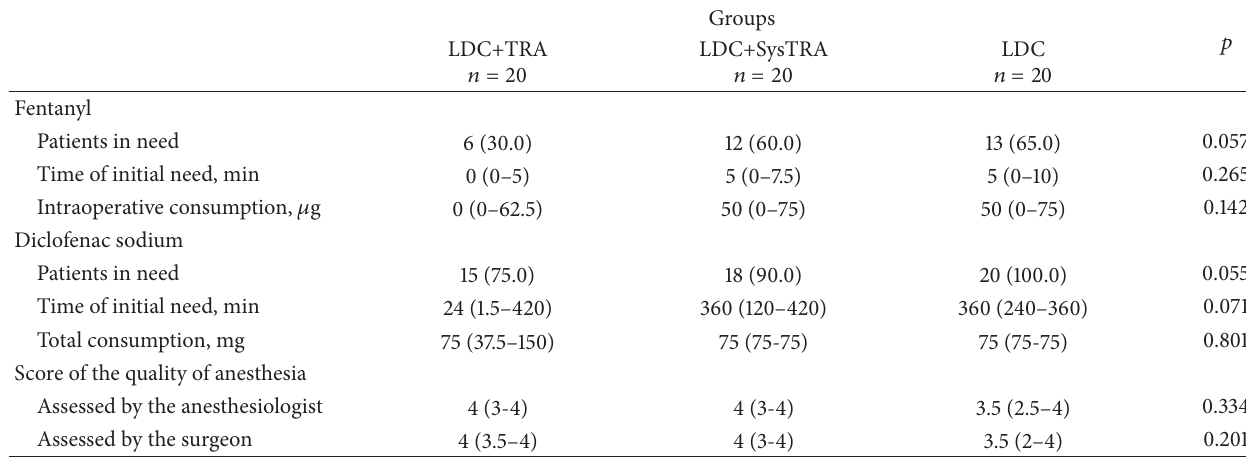
Table 4: Patients’ need for analgesics and evaluation of quality of anesthesia.